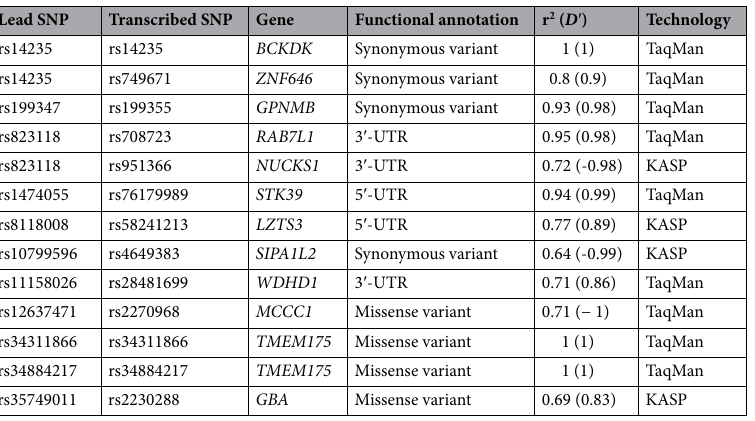
Table 1. Lead and transcribed, proxy SNPs selected for allelic expression analysis. SNP single nucleotide polymorphism, 3 ′ UTR three prime untranslated region, KASP Kompetitive Allele Specific